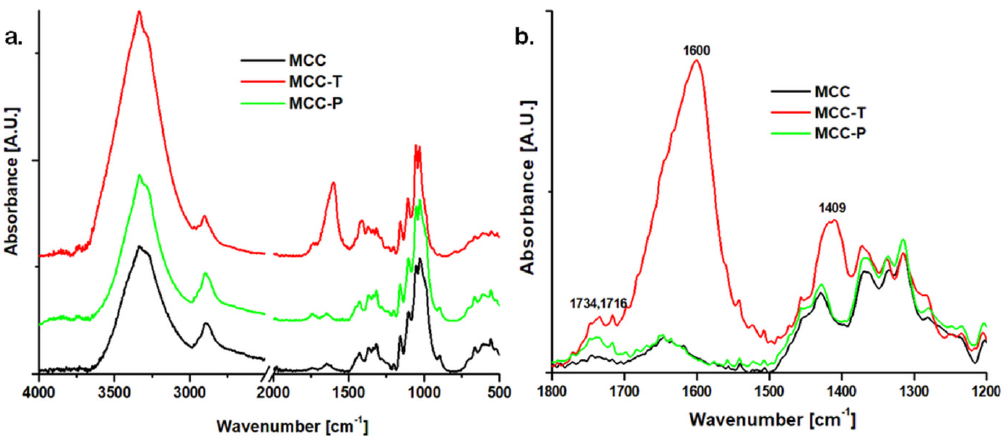
Figure 4. FTIR spectra of MCC, MCC-T and MCC-P ( a ); FTIR spectra in the range from1800 to 1200 cm − 1 ( b ) .